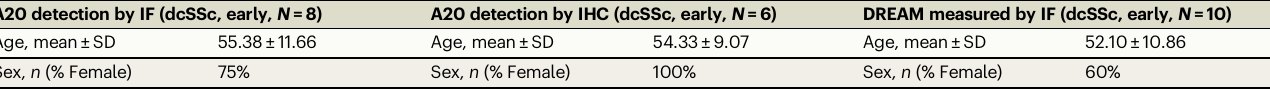
Table 1 | Clinical characteristics of SSc subjects A20 detection by IF (dcSSc, early, N =8) A20 detection by IHC (dcSSc, early, N =6) DREAM measured by IF (dcSSc, early, N